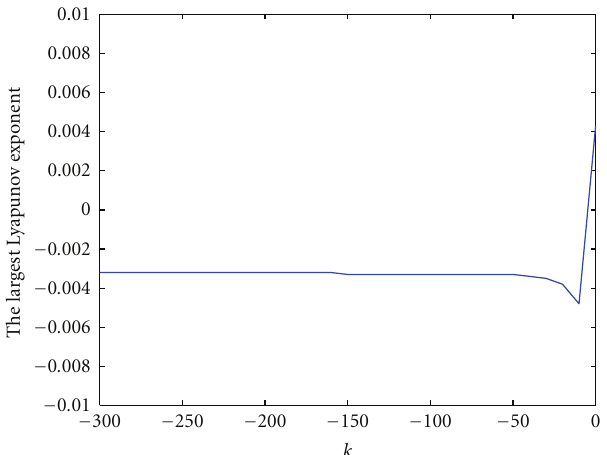
Figure 13: The relationship of the largest Lyapunov exponent (LLE) and k for m = − 250